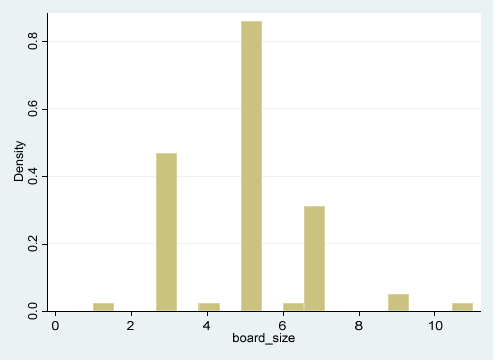
Figure 1. Board Size.